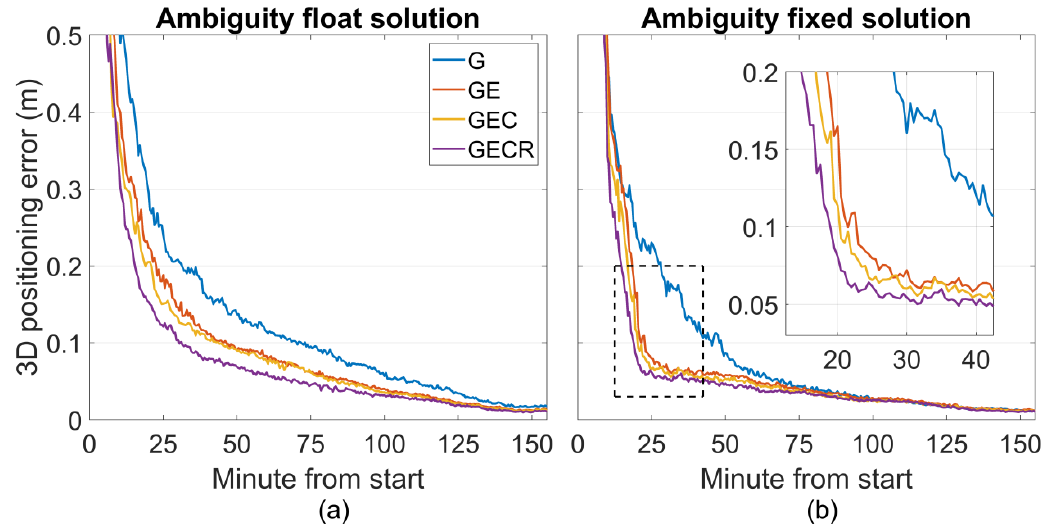
Figure 6. ( a ) The 3D ambiguity float positioning errors and ( b ) 3D ambiguity fixed positioning errors of di ff erent combinations in kinematic mode with a 90%